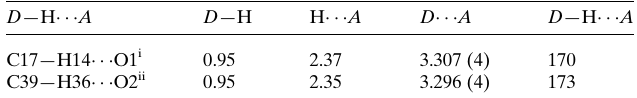
Table 1 Hydrogen-bond geometry (A˚ , (cid:2) ).